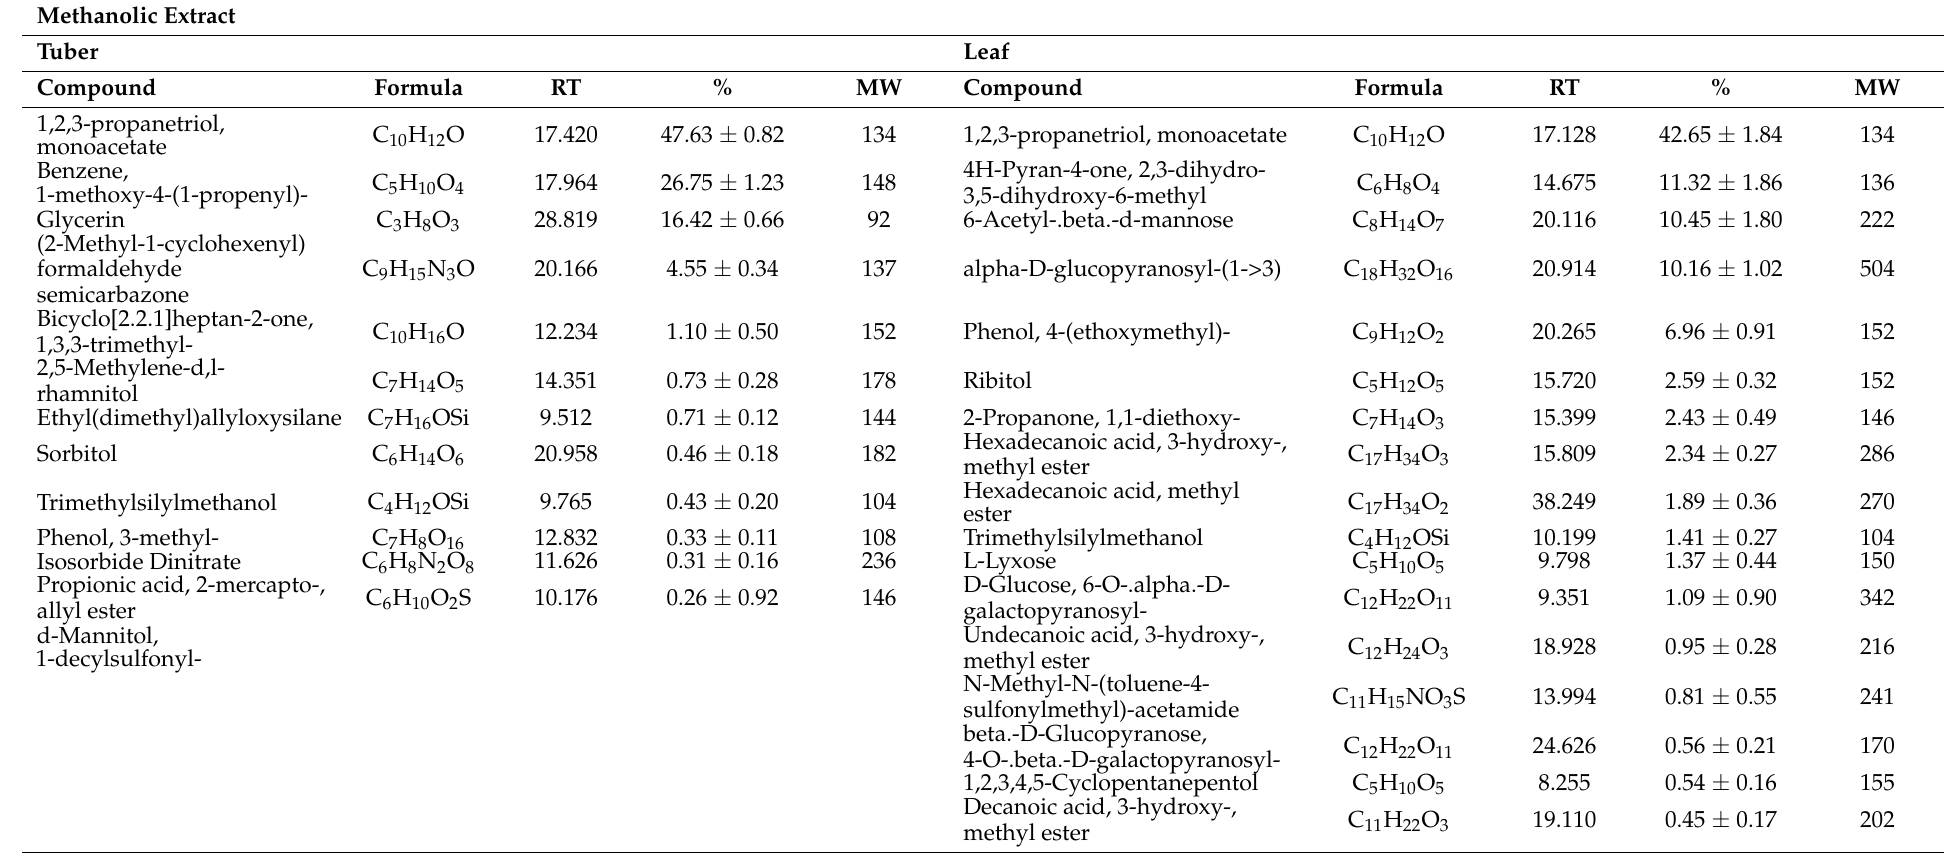
Table 3. The phytochemical components of methanolic and ethanolic extracts of tuber and leaf in H. affine (Boiss.) Schltr. identified by gas chromatography–mass spectrometry (GC–MS)